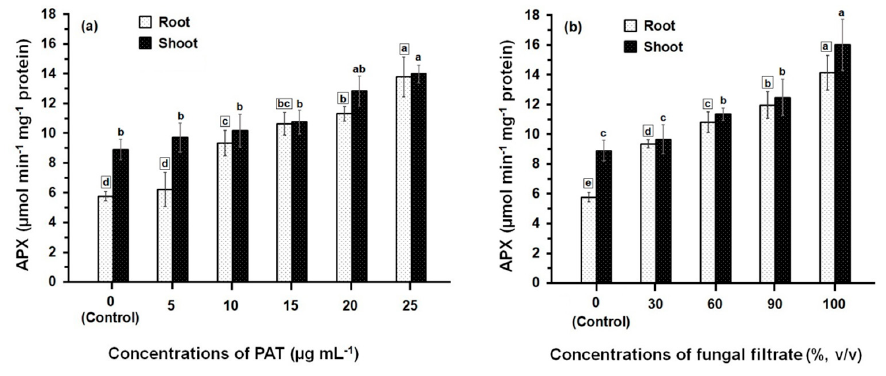
Figure 2. APX activity in root and shoot of 8-day-old maize seedlings treated with different concentrations of PAT ( a ) and fungal filtrate ( b ). In this figure, data are shown as the mean ± SD of triplicate measurements from three independent experiments. Different letters either for roots (in small squares) or shoots (without squares) at different concentrations are statistically different (LSD test, p ≤ 0.05).